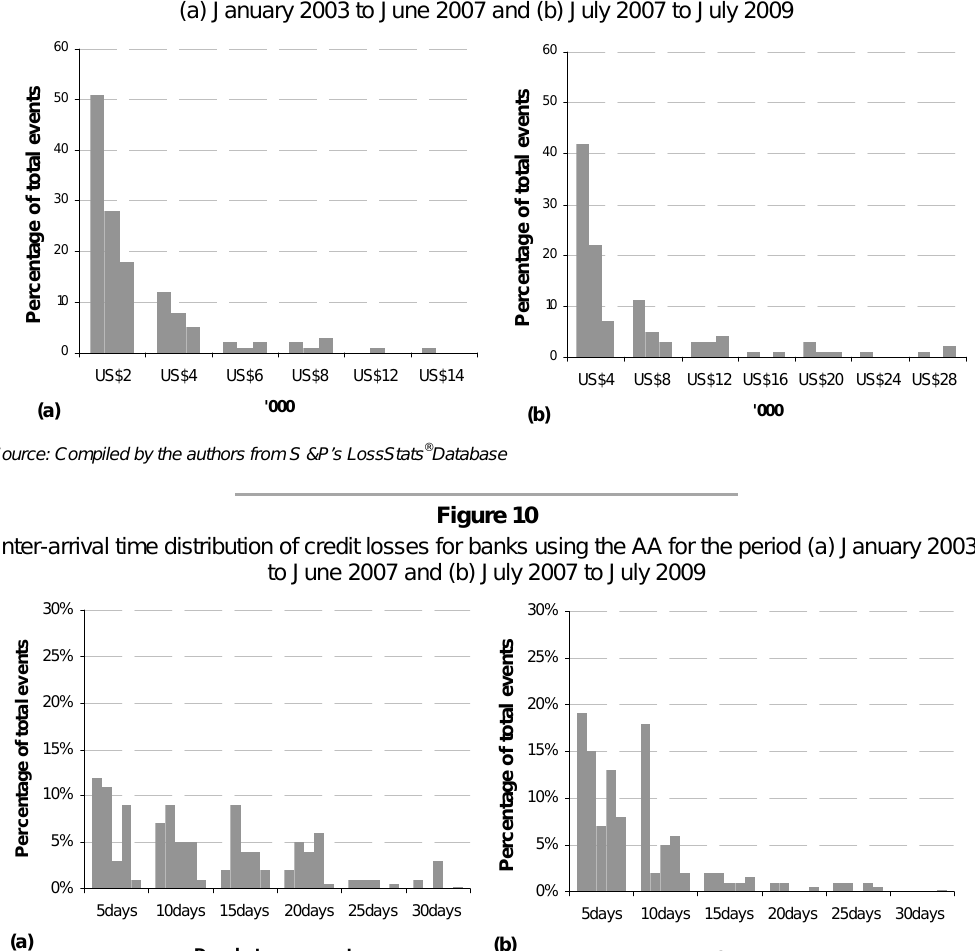
Loss severity for banks using the AA – histograms and distributions for the period (a) January 2003 to June 2007 and (b) July 2007 to July 2009